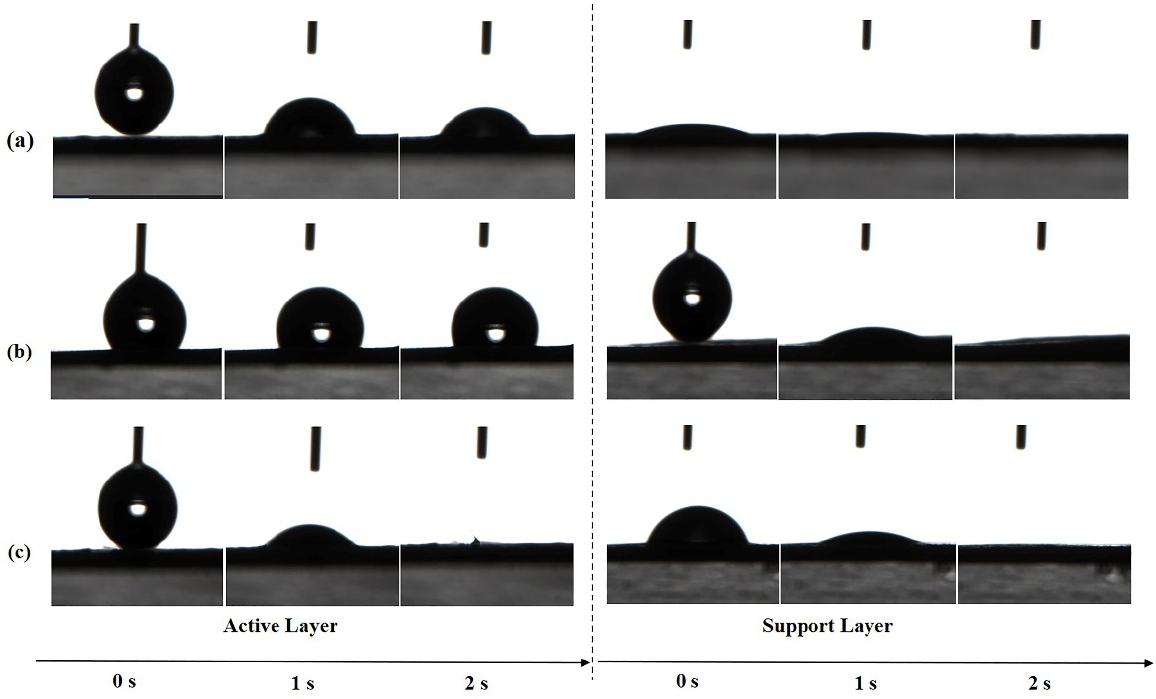
Figure 8. The changes of water contact angles (WCA) of the nanofiber TFC FO membranes prepared with different heat-curing methods over time: ( a ) n-TFC; ( b ) o-TFC; ( c ) w-TFC.